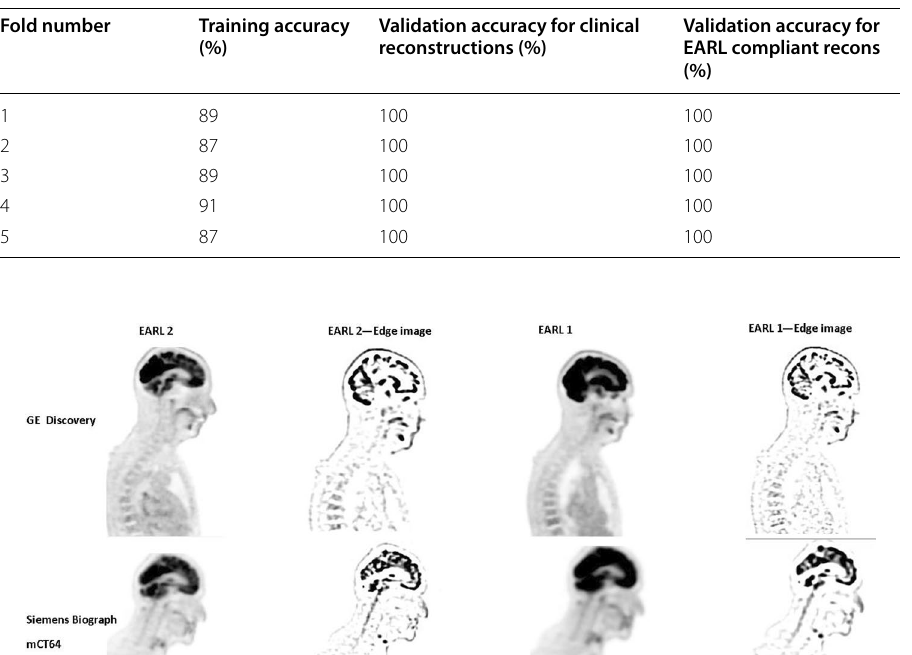
Table 2 Training and cross-validation accuracy for the first CNN trained to separate clinical and EARL compliant reconstructions